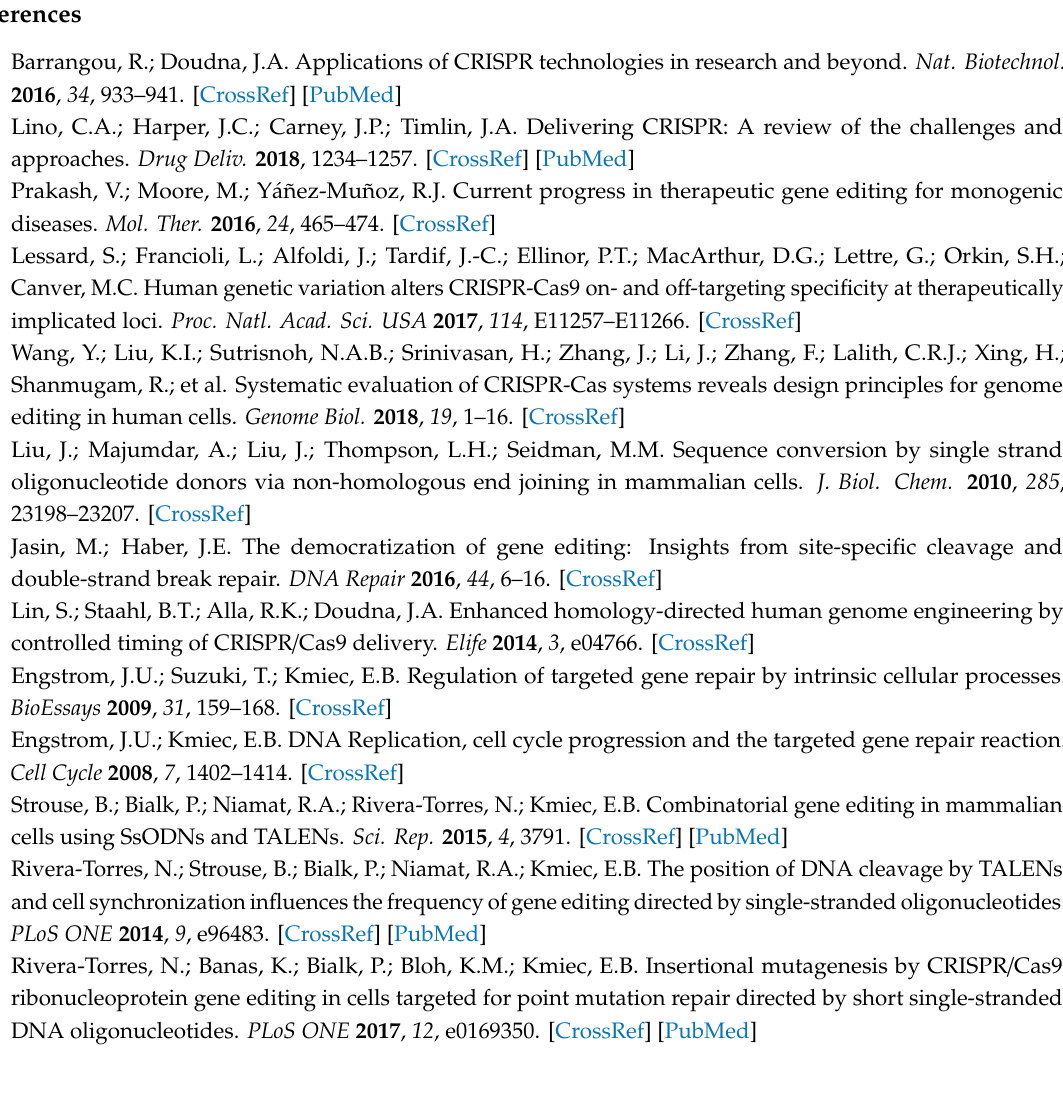
Figure S1A–C: Additional data for Figure 3A–C—symmetrical homology arm lengths using CRISPR / Cas12a, Figure S2A–C: Additional data for Figure 4A–C—symmetrical homology arm lengths using CRISPR / Cas9, Figure S3A,B: CRISPR / Cas control with and without cell-free extract, Figure S4A,B: Comparison of direct in